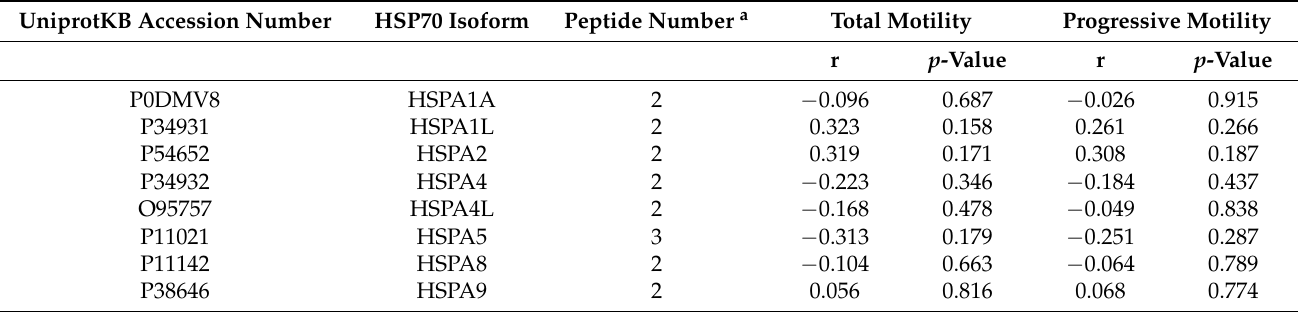
Table 3. Correlation analysis between the relative abundance of HSP70 isoforms in human spermato- zoa and percentage of motile and progressive spermatozoa in the raw semen samples.